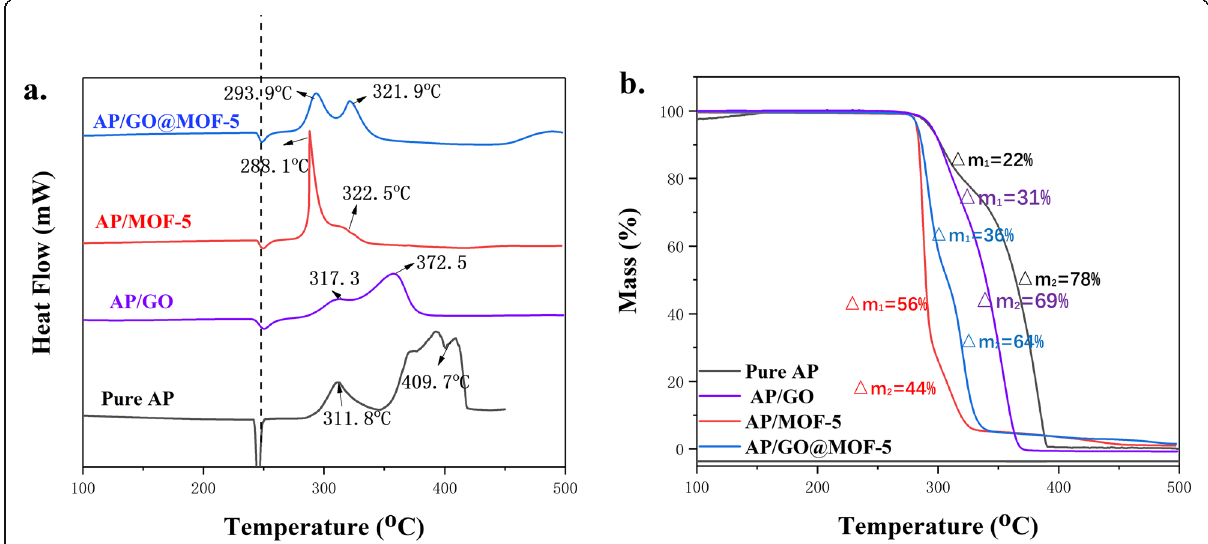
Fig. 7. a DSC curves and b TG curves of AP composite samples (10 °C/min, N 2 atmosphere)